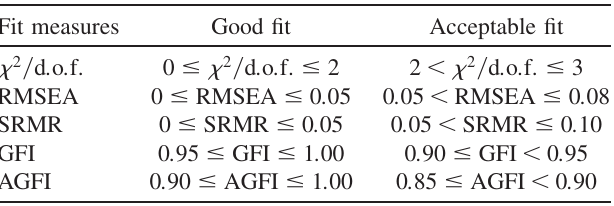
TABLE II. The rule of thumb criteria for goodness-of-fit in- dices. (Adapted from Schermelleh-Engel et al. [41].)